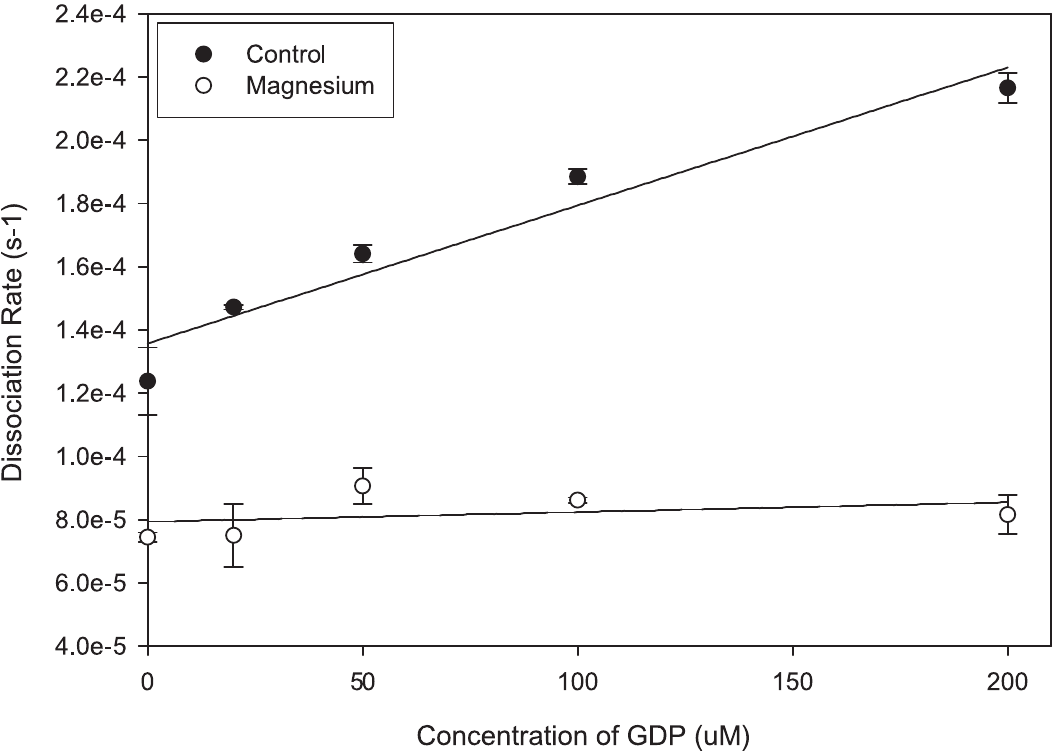
Figure 2. TC10 nucleotide exchange is inhibited by 10 mM MgCl 2 . TC10-mantGDP complexes were prepared in the presence of magnesium and then exchanged into buffer with or without 10 mM MgCl 2 . Release rates were determined from exponential decay curves and plotted versus the concentration of free GTP. Data are presented as mean with standard error bars.